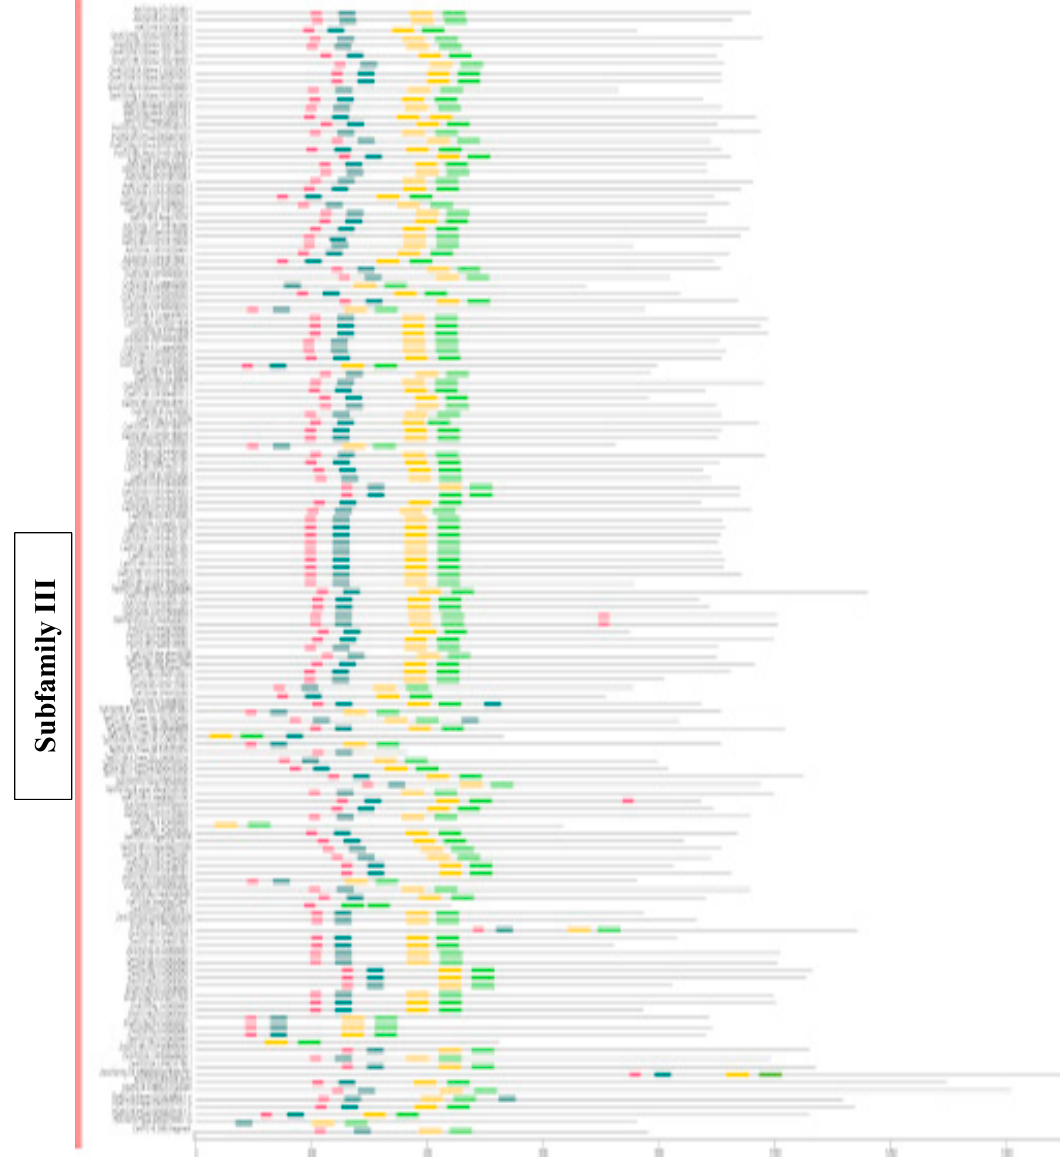
Figure 8. Protein motifs of the ATG18b family from different plant species. The conserved motifs were identified with MEME. The amino acid sequence of the ATG18 family is represented by lines, and the motifs identified using TBtools are shown with boxes: Motif 1 (green), motif 2 (yellow), motif 3 (dark green) and motif 4 (pink).